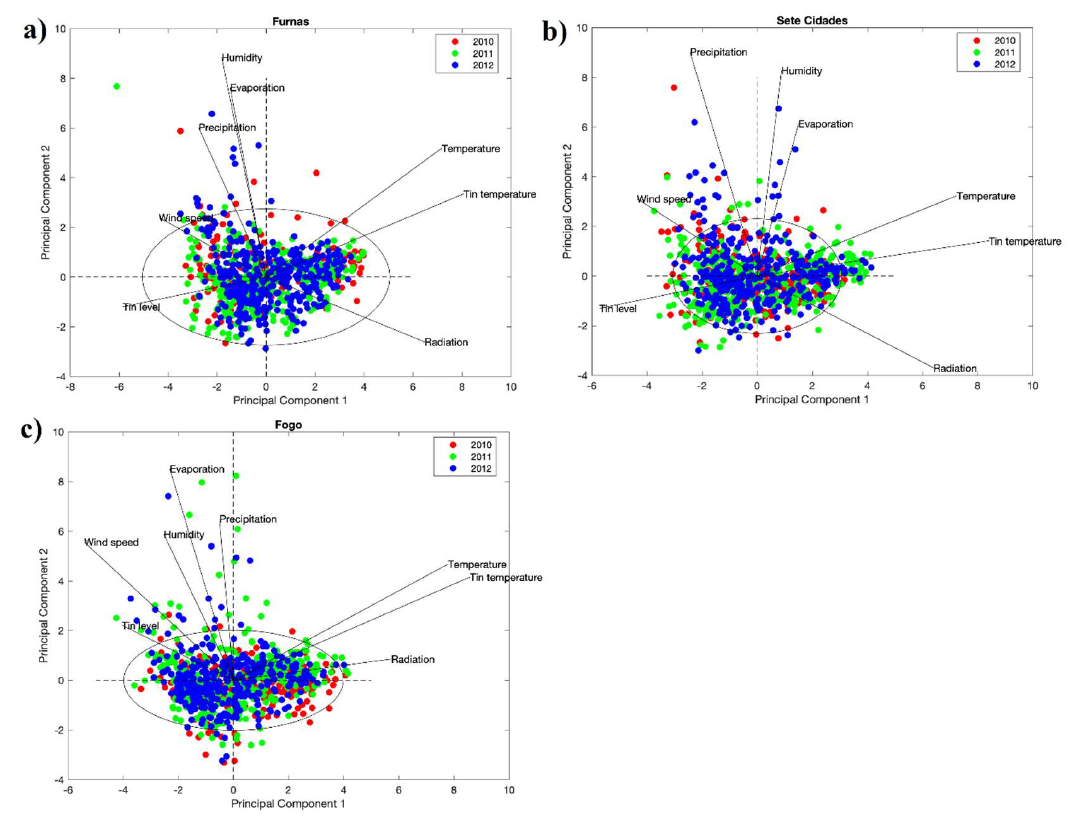
Figure 9. Biplots for the multivariate analysis of the meteorological data, colored according to the year of collection for each one of the volcanic lakes: Furnas ( a ), Sete Cidades ( b ) and Fogo ( c ).